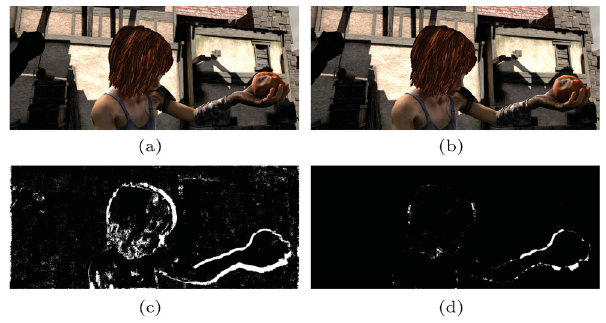
Fig. 6 Effects of our label set modification strategy for an image pair with small displacement. Pixels having a good label set are black, and others are white. (c) and (d) visualize label set quality before and after optimization. The percentage of the black pixels increases from 93 . 1% to 99 . 1%.